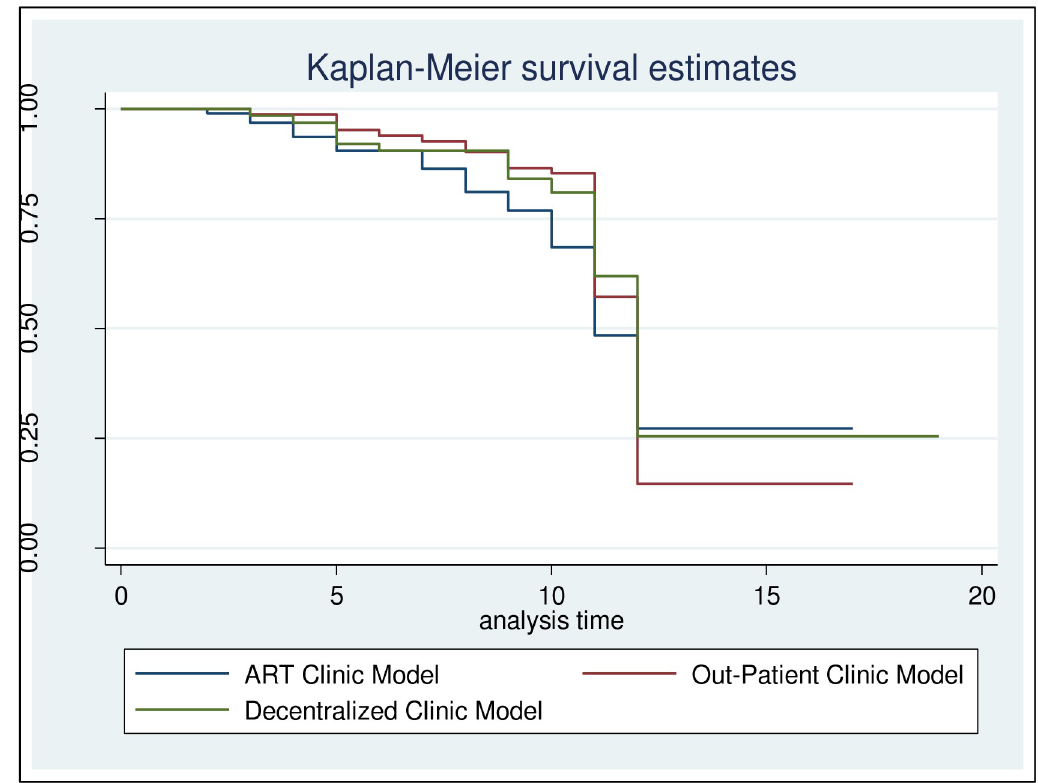
Fig 2. Retention rate of the couples by the three models. Log-rank trend test of equality of survivor functions, x2 = 0.75, p- value = 0.3852.